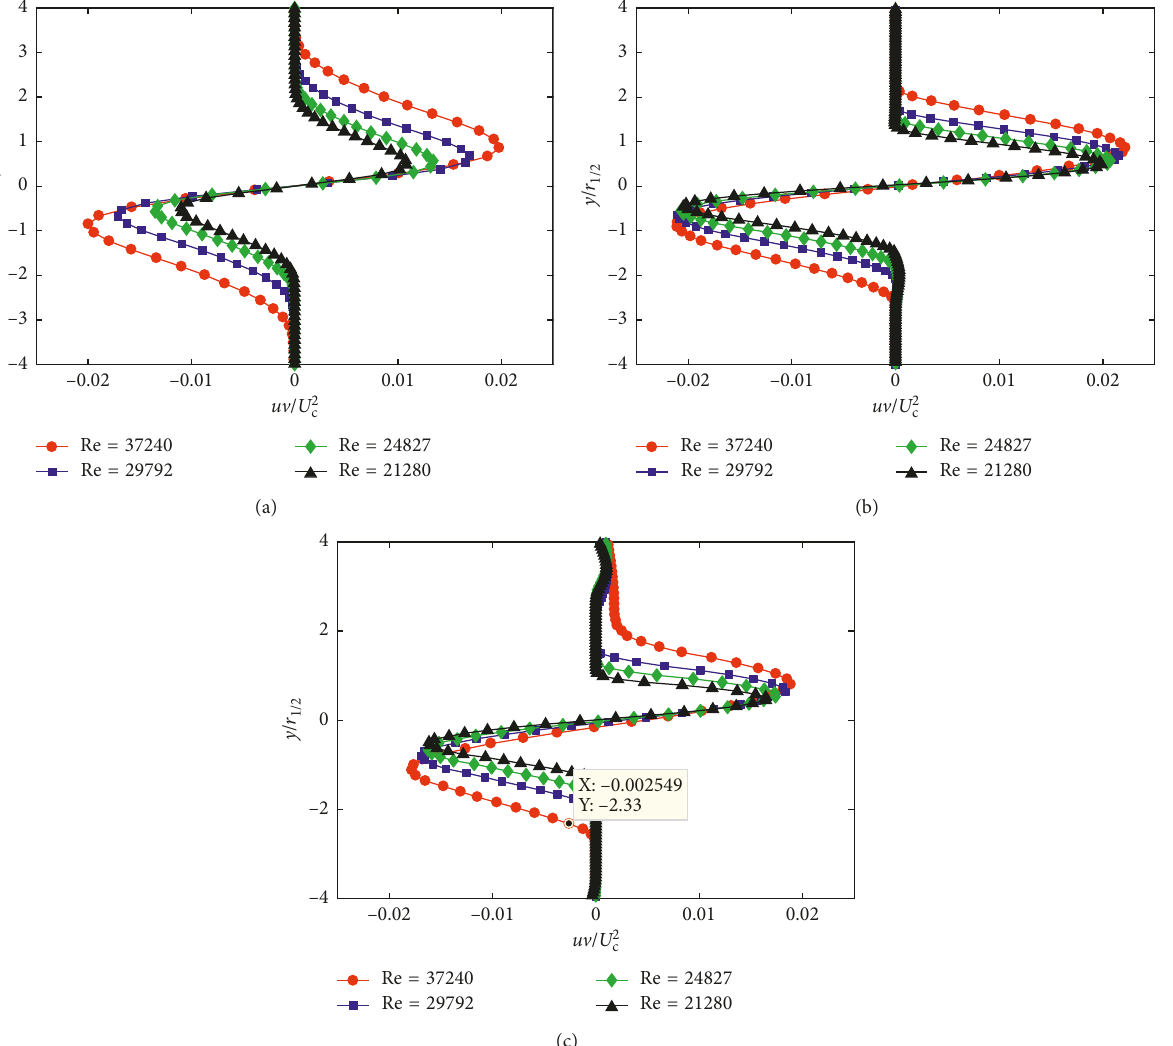
Figure 8: The profile of shear stress uv / U 2 in the standard case) in the Y